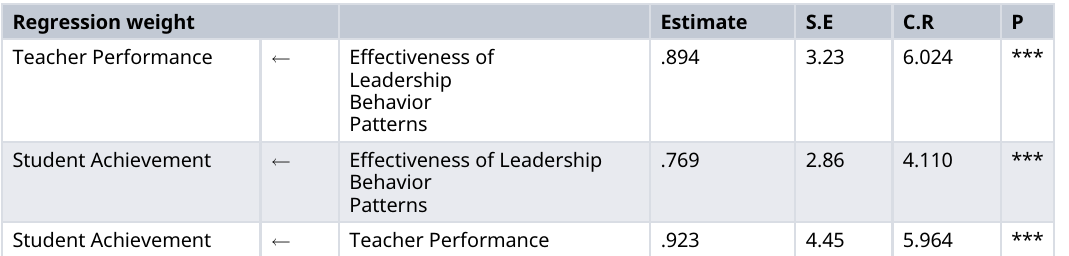
Table 5. Regression